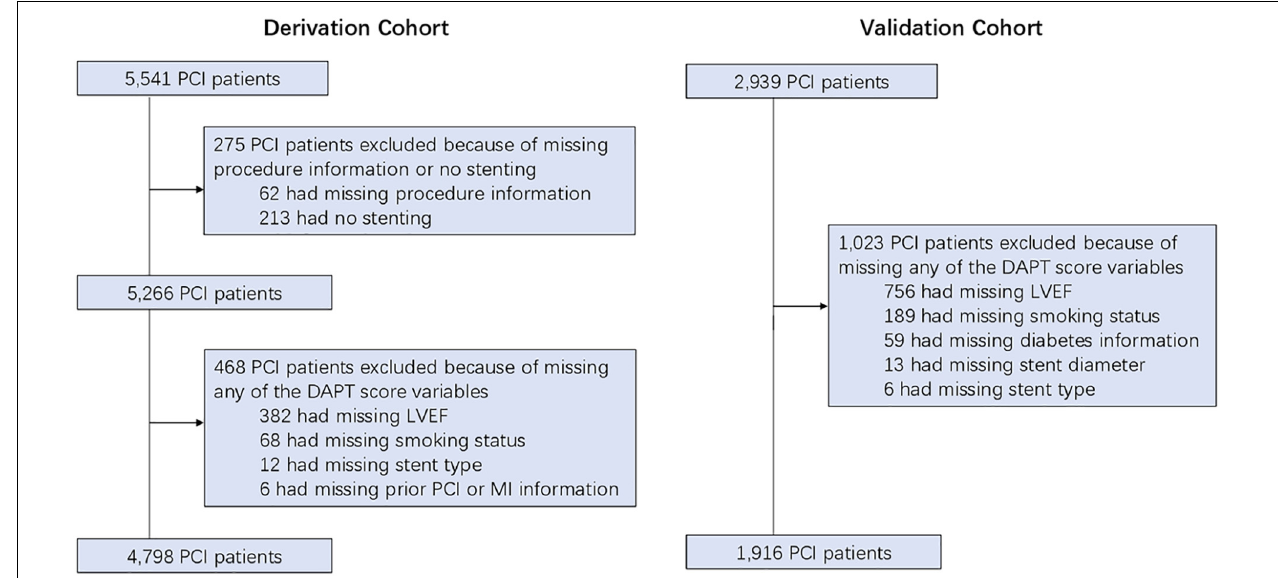
FIGURE 1 | The study flow-chart. PCI, percutaneous coronary intervention; DAPT, dual antiplatelet therapy; LVEF, left ventricular ejection fraction; MI, myocardial infarction.